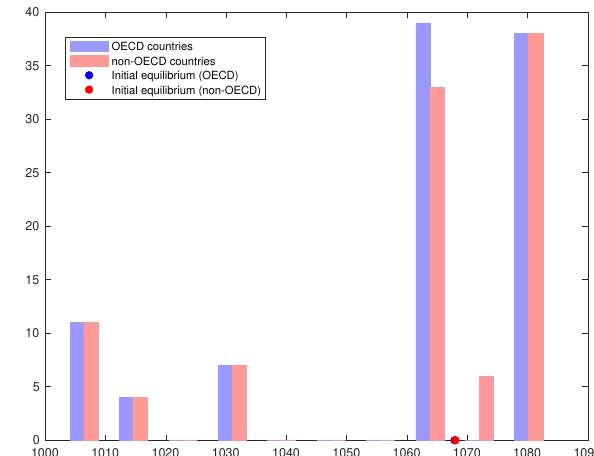
Figure A9. Simulation with ˙ k , Λ stochastic: equilibrium values.